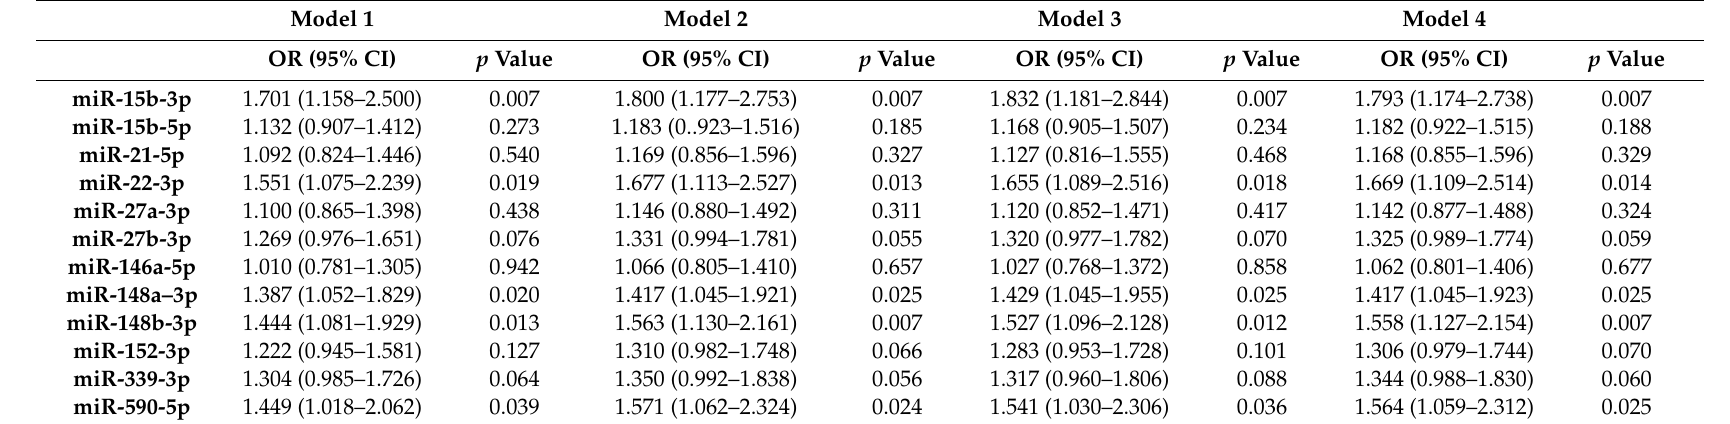
Table 2. Association between circulating microRNAs and epicardial fat